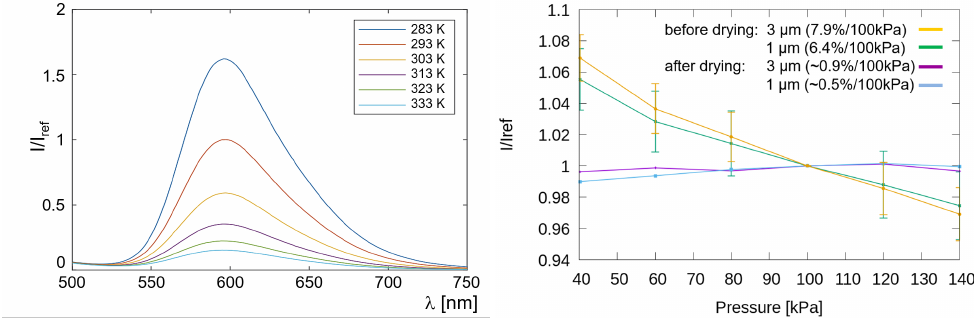
Figure 2. ( Left ) Emission spectra for TSP calibrated at p ref = 100 kPa for various temperatures. ( Right ) pressure dependency of TSP for different layer thicknesses, before and after drying and illuminating, from [17].